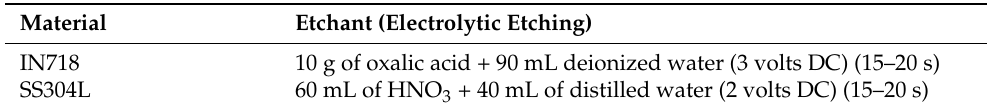
Table 3. Etchant